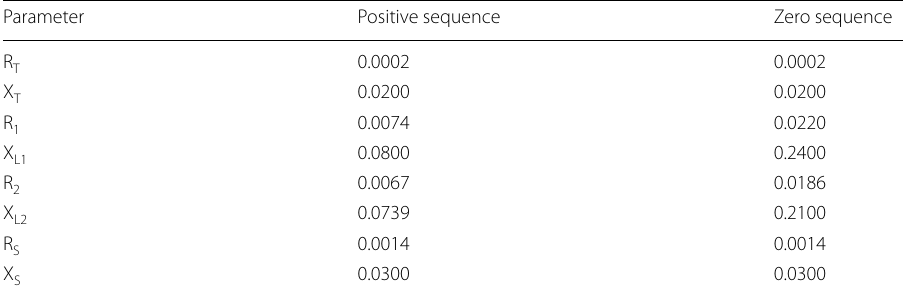
Table 3 IEEE second benchmark impedances in p.u